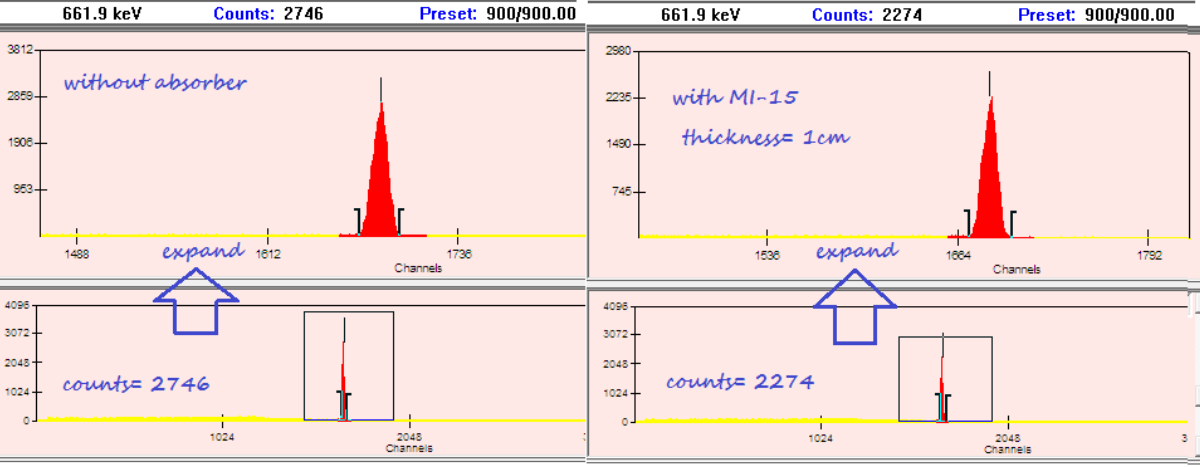
Figure 4. The spectrum with and without absorber at 0.662 MeV line.